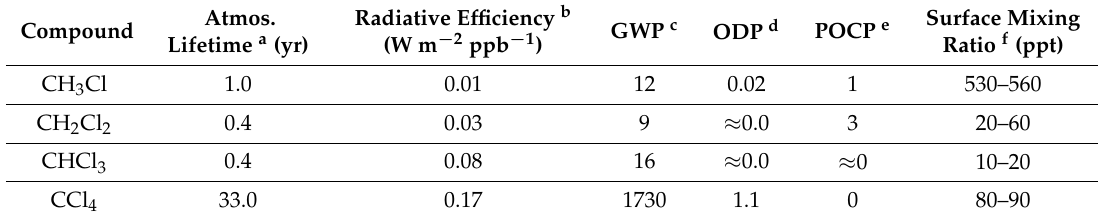
Table 5. Environmental properties of